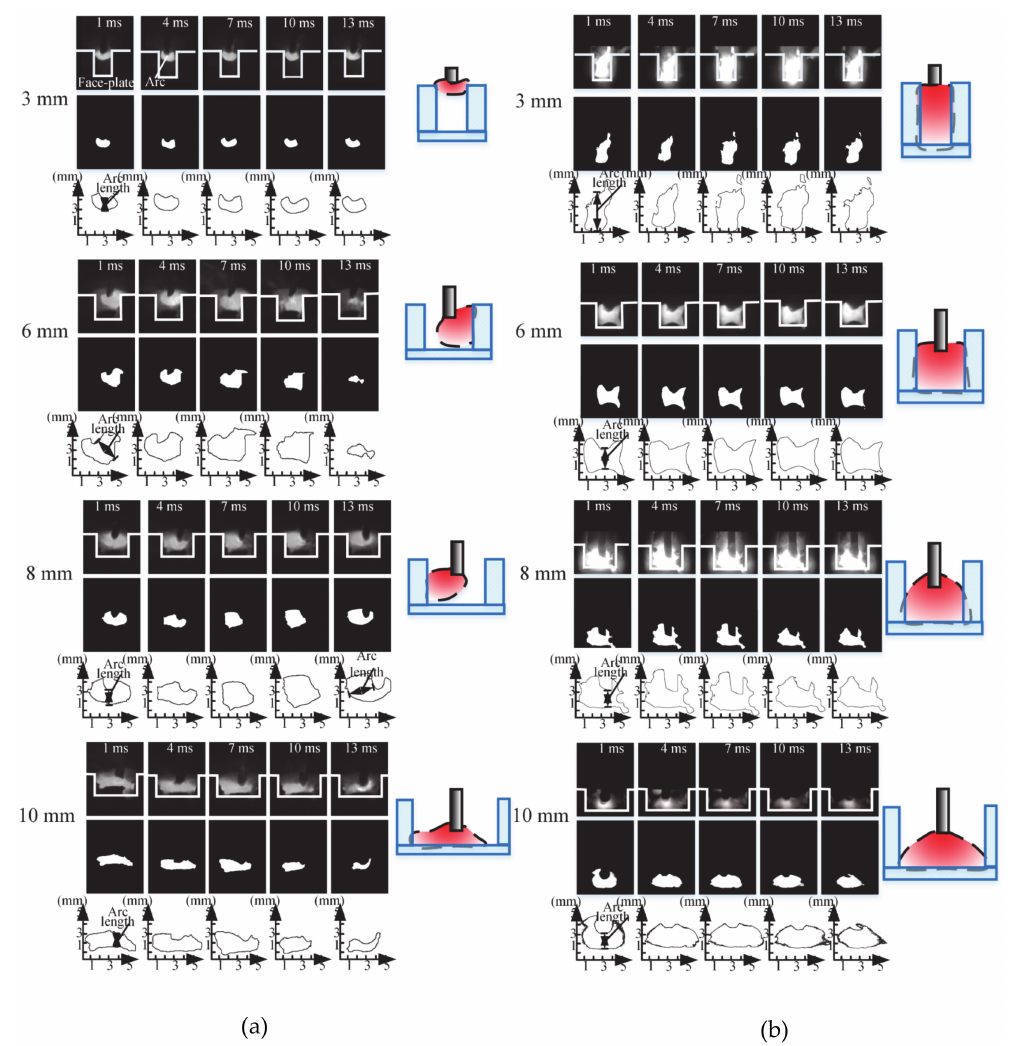
Figure 10. Simplified arc shape in the ( a ) GMAW and ( b ) FBCA welding process under the ultra-narrow groove